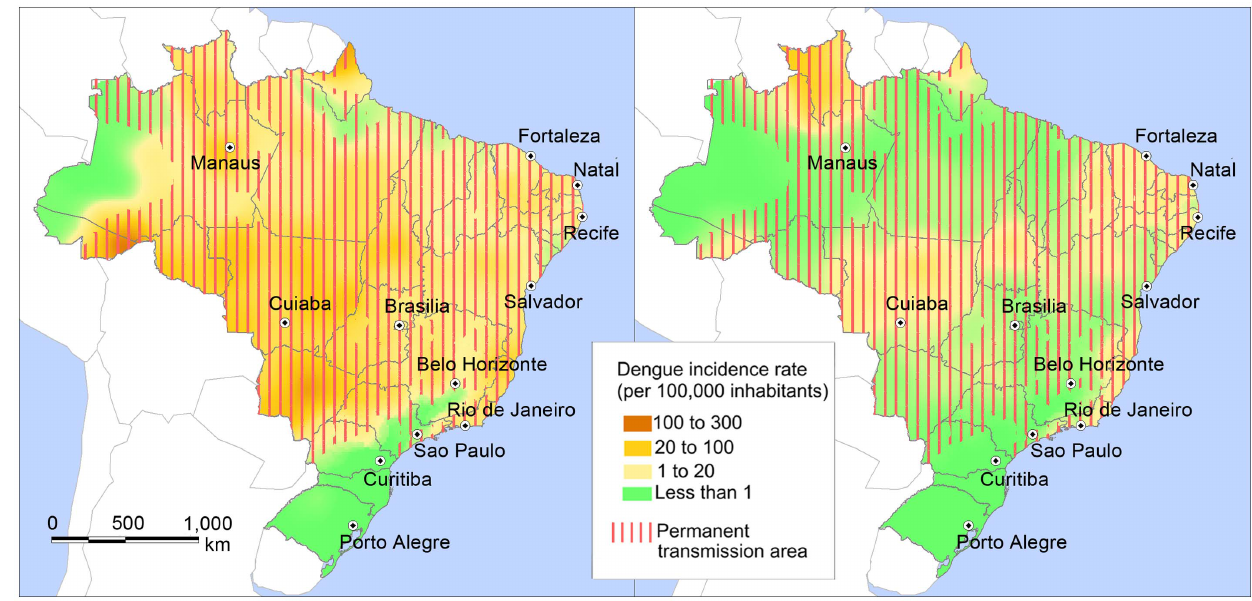
Figure 1. Average dengue incidence rates (per 100,000 inhabitants) for February (left) and June (right) 2001–2012.